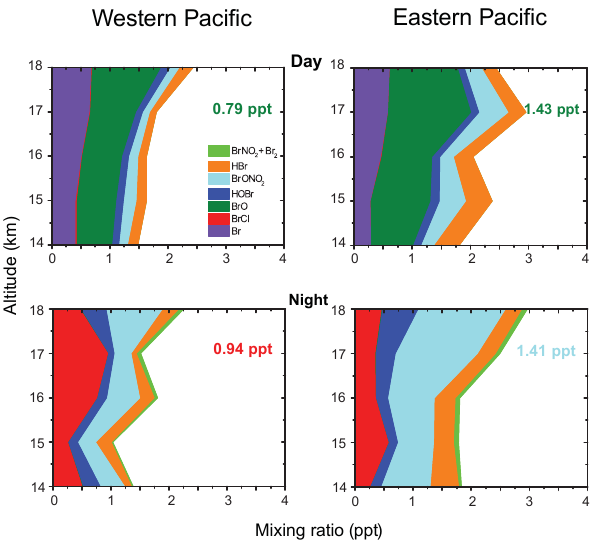
Figure 4. Model calculations of inorganic bromine partitioning along ATTREX flight tracks over the WP and EP using CAM- Chem with prevailing atmospheric conditions (specified meteorol- ogy) during the ATTREX campaign. Numbers inside the boxes rep- resent the mixing ratios of BrO (green), BrCl (red), and BrONO 2 (light blue) at 17km.